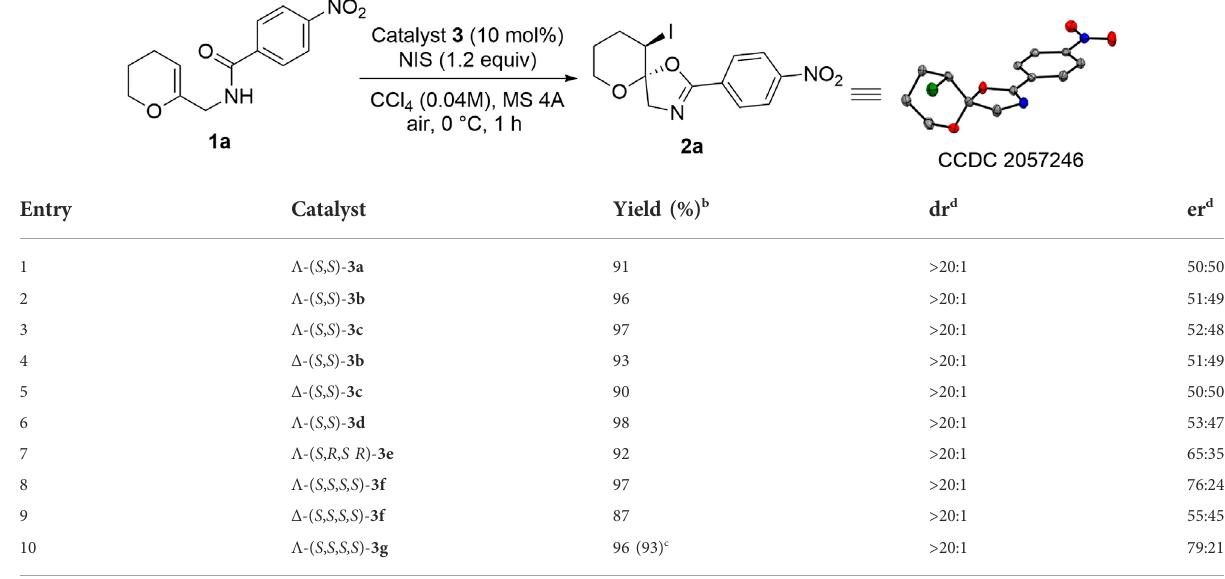
Entry Catalyst Yield (%) b